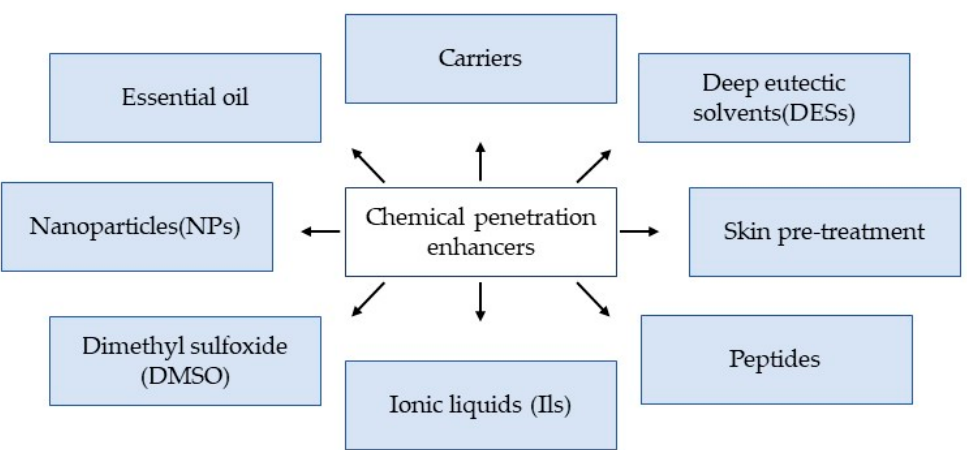
Figure 3. Different types of chemical enhancers that have been used for the delivery of insulin and other pharmaceutical drugs.